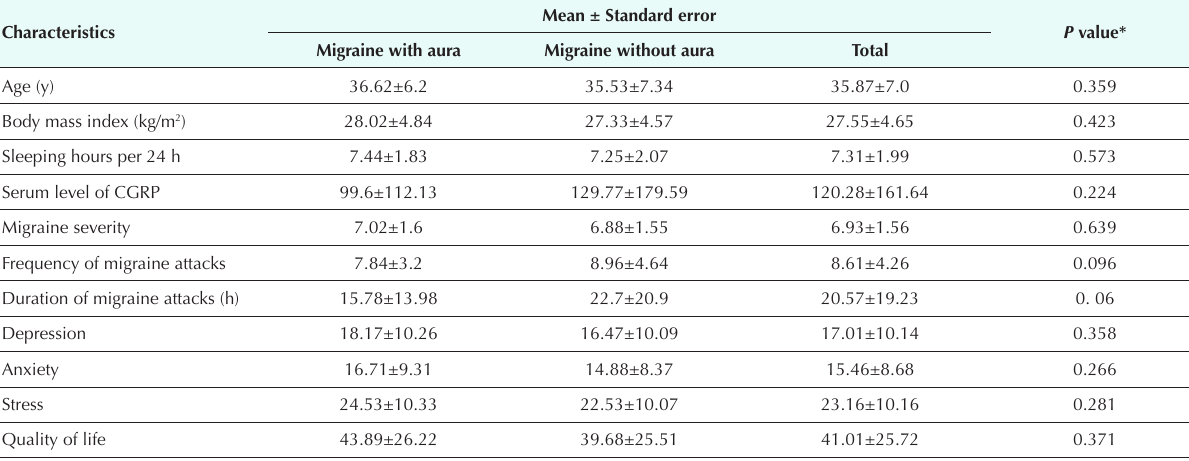
Table 1. Comparison of patients with aura and patients without aura respecting their characteristics Characteristics